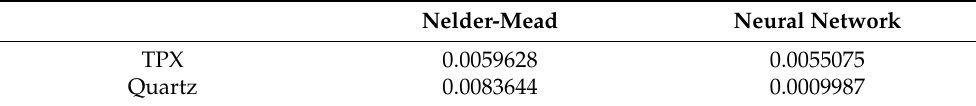
Figure 6. Comparison of extracted optical constants between neural network method and Nelder-Mead algorithm for quartz with a thickness of 1.068 mm: ( a ) refractive index and ( b ) extinction coefficient. Table 3. MAE for TPX and z-cut quartz with the Nelder-Mead algorithm and Neural network